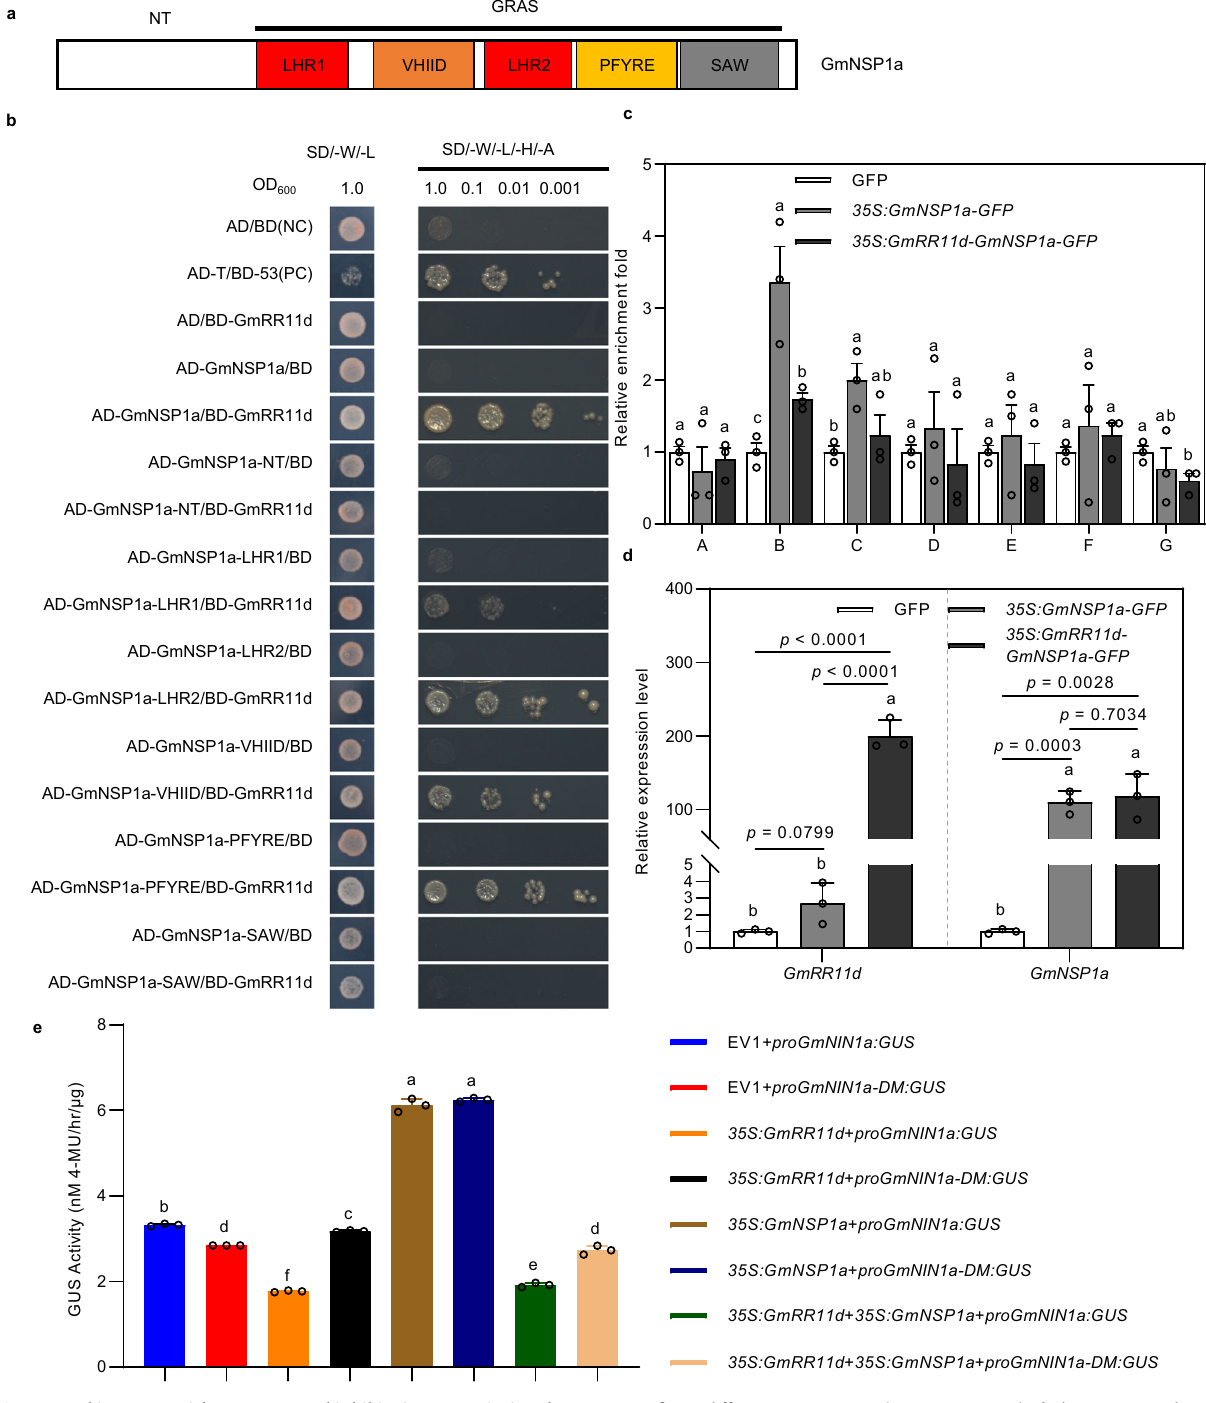
signi fi cant differences at P <0.05 (One-way ANOVA). d The expression level of GmRR11d and GmNSP1a in hairy root expressing 35S : GmNSP1a-GFP or 35S : GmRR11d-GmNSP1a-GFP . Data are presented as means±SD of three biological repeats. More than 30 hairy roots were analyzed in three independent biological repeats. Different letters indicate signi fi cant differences at P <0.05 (One-way ANOVA). e GUS activity of proGmNIN1a : GUS and proGmNIN1a-DM : GUS with dif- ferent combinations with 35S : GmRR11d , 35S : GmNSP1a and 35S : GmRR11d + 35 S : GmNSP1a in N.benthamiana leaves.Dataarepresentedasmeans±SDfromthree biologicalrepeats.Differentlettersindicatesigni fi cantdifferencesat P <0.05(One- way